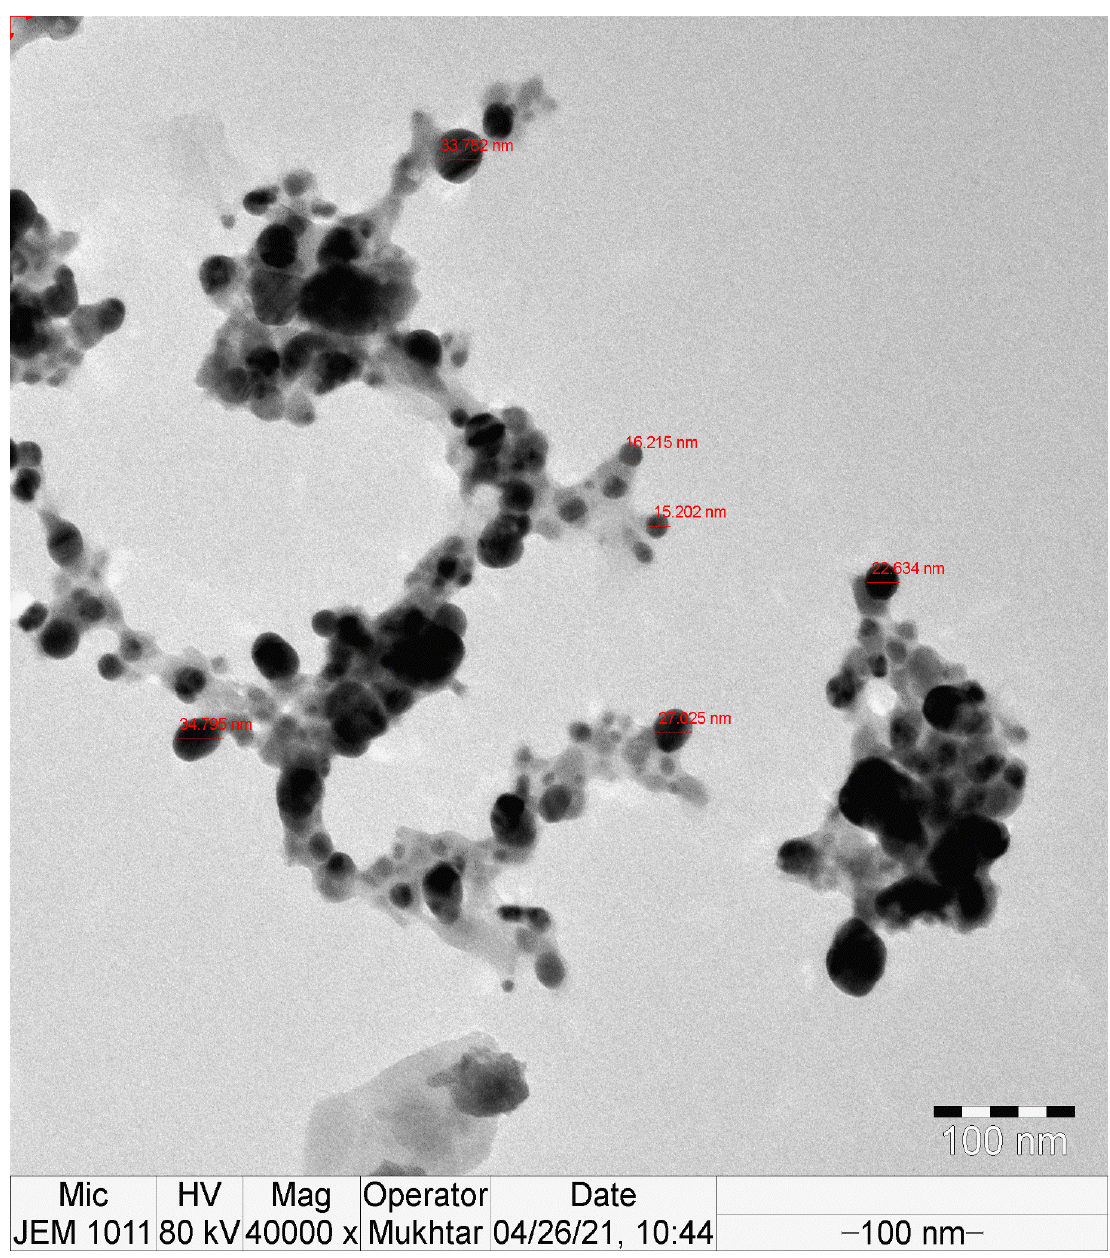
Figure 3. TEM micrograph of the bioinspired silver nanoparticles synthesized using aqueous peel extract of Punica granatum .